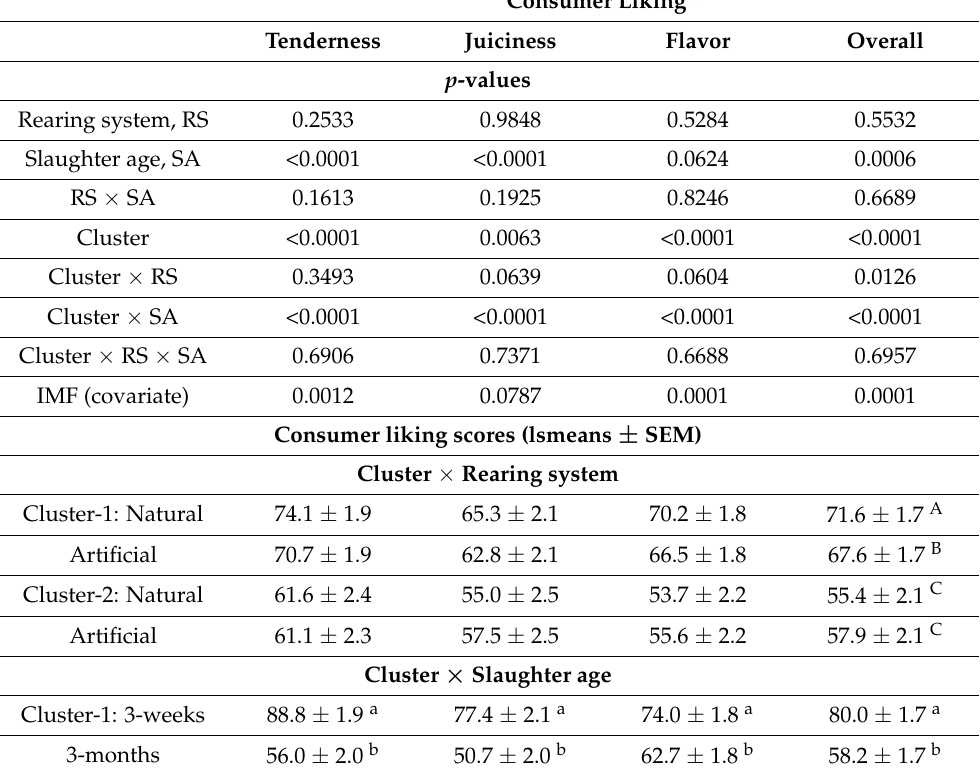
Table 4. Consumer clusters (cluster), lamb rearing system, and slaughter age effects on consumer liking of